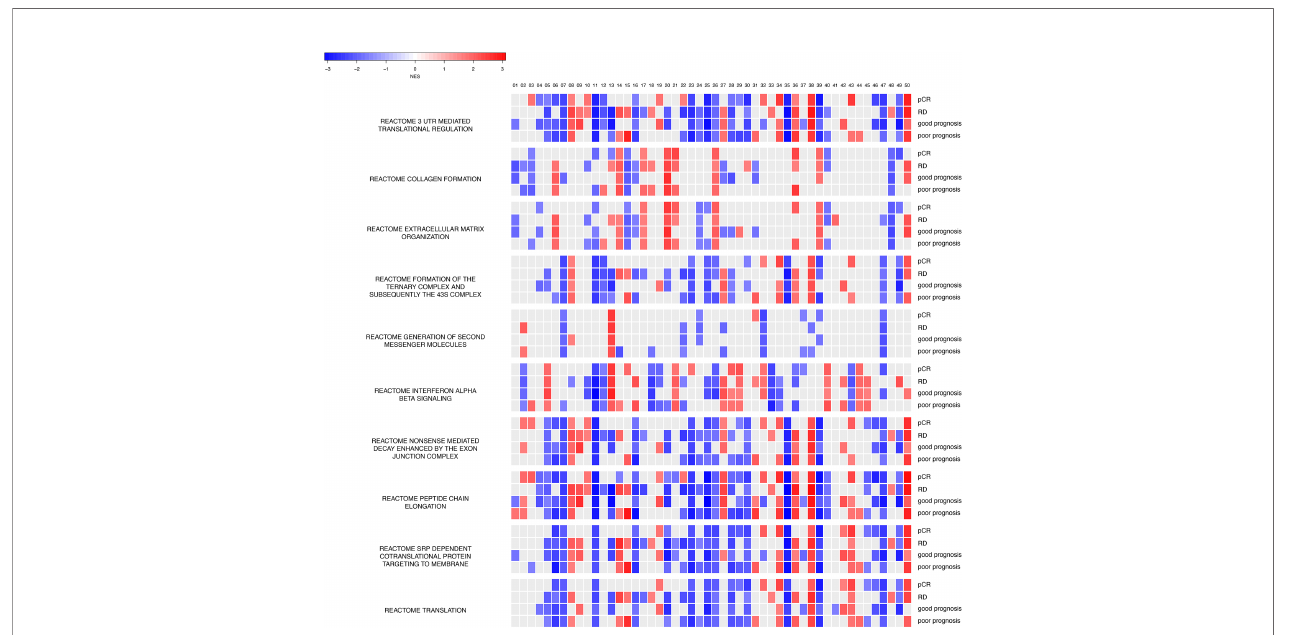
FIGURE 6 | Hidden nodes store biologically meaningful information. GSEA enrichment analyses for protein-protein interactions using the REACTOME database for top hidden nodes in ANNE trained model. Enriched interactions with normalized enrichment scores with absolute values greater than 1.5 and false discovery rate (FDR) < 0.05 are indicated. pCR, chemosensitive model; RD, chemoresistant model. The order of the 50 hidden nodes is indicated at top of the fi gure.